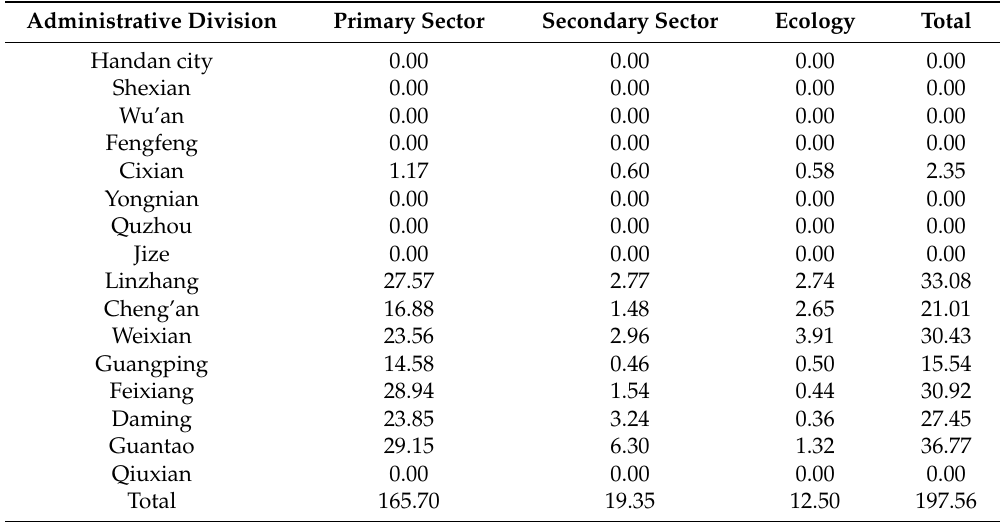
Table 9. Results for Yuecheng reservoir allocated to every user (10 6 m 3